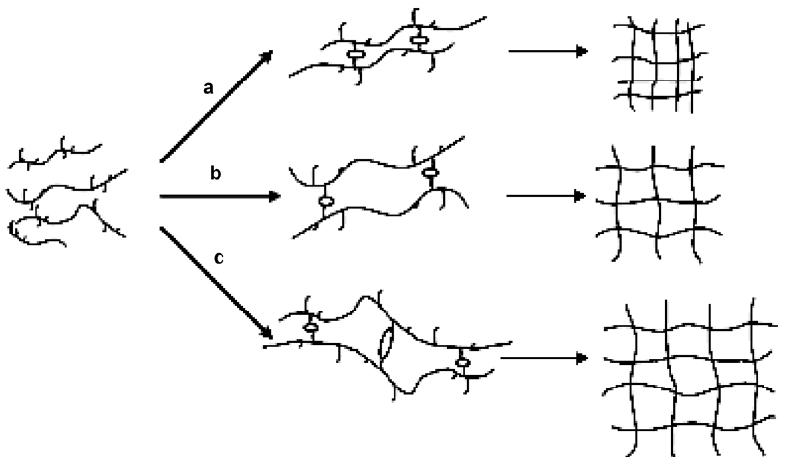
Figure 24. Aggregation patterns for various grades of HPMC having different substitution ratio and molecular weight as: ( a ) network of HPMC-A with small cells; ( b ) network of HPMC-B with larger cells at lower cross-linking density; ( c ) network of HPMC-C with large cells at the highest cross-linking